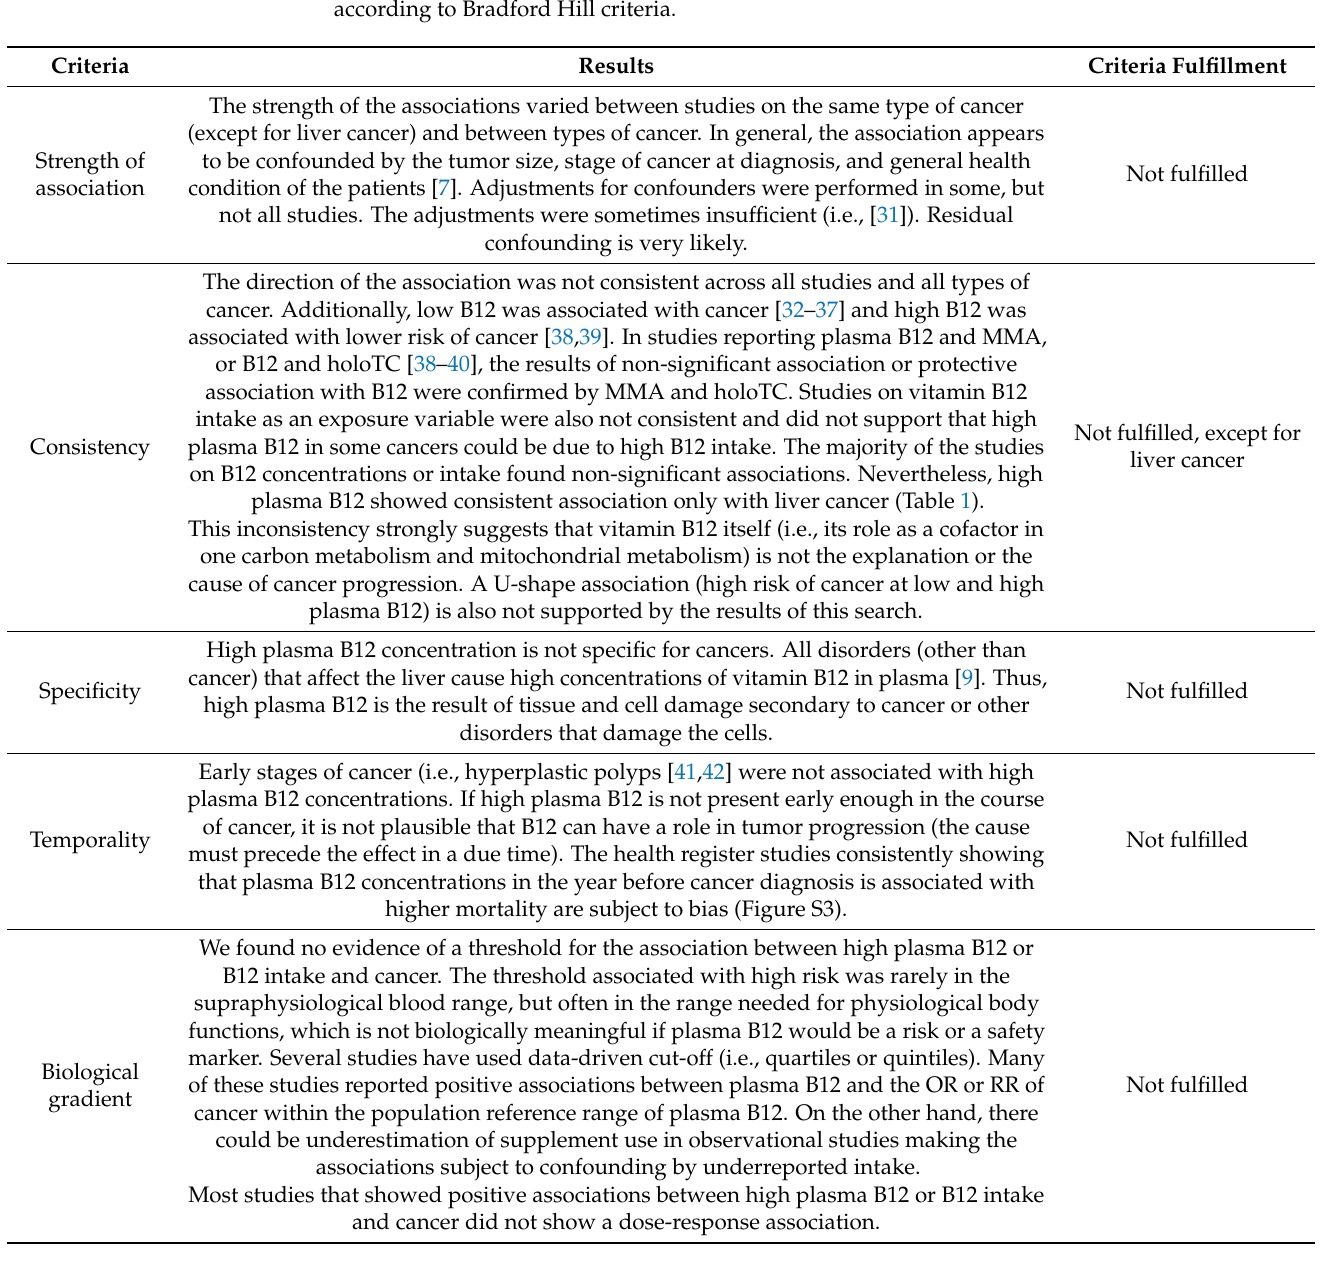
Table 2. Evaluation of the causal link between high vitamin B12 (concentration or intake) and cancer according to Bradford Hill